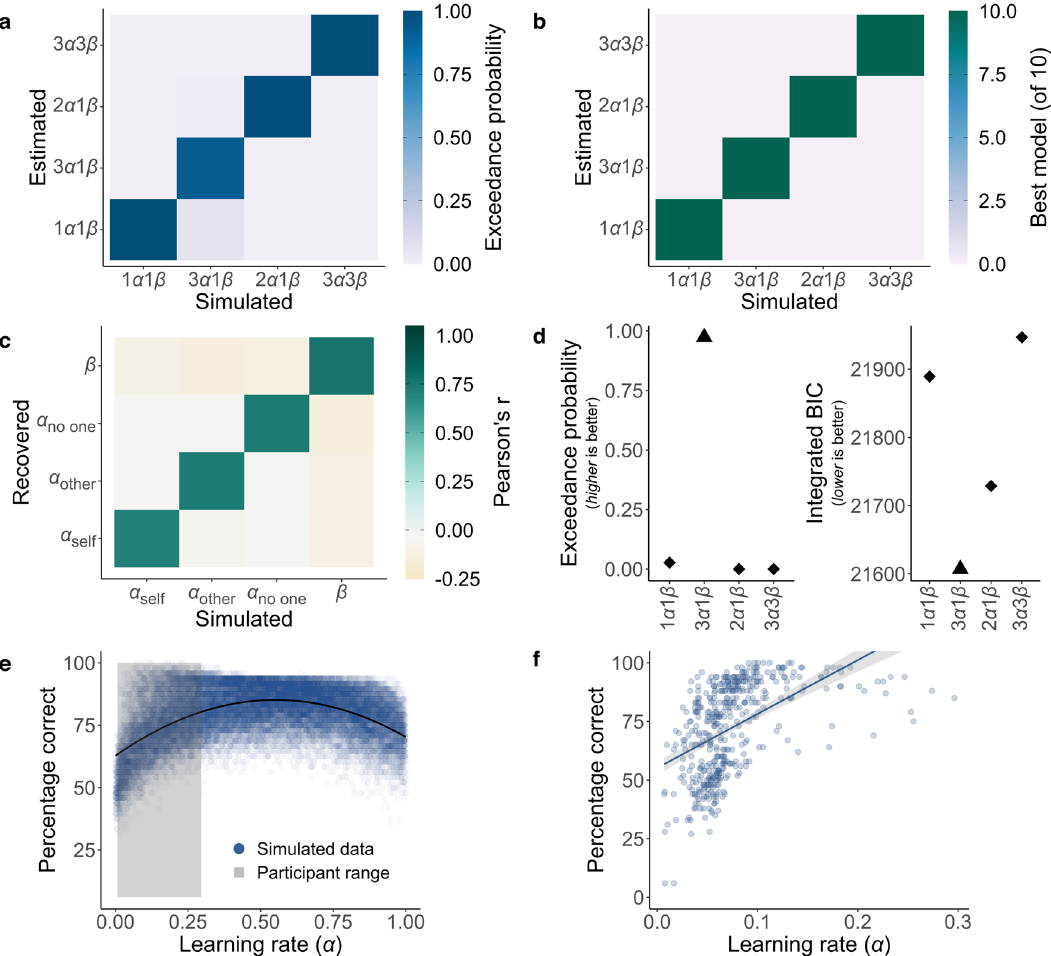
Fig. 2 Model identi fi ability, parameter recovery, model comparison and optimal learning rate. a Model identi fi ability average exceedance probability confusion matrix and b model identi fi ability best model selection confusion matrix. Data were simulated from 150 synthetic participants with each of our four models then Bayesian model selection was applied, and this procedure was repeated ten times. Identi fi ability is shown by strong diagonals. c Parameter recovery was performed on data simulated by the winning 3 α 1 β model from 1296 synthetic participants. The confusion matrix represents correlations between simulated and fi tted parameters. Stronger colours show higher values and high values on the diagonal show parameters can be recovered. d The 3 α 1 β model (triangle) is the best model on both exceedance probability and integrated Bayesian Information Criterion (BIC) fi t measures. e Average percentages of correct choices (high probability of reward option) associated with 30,000 simulated α values (10,000 synthetic participants, three recipient conditions; blue dots) show that an optimal learning rate is approximately 0.55 in this task. The range of α values for our participants was below this peak (grey shading), such that a higher learning rate was associated with better performance. f Correlation between percentage correct and learning rate across participants. There was a signi fi cant Spearman ’ s Rho correlation between learning rate and accuracy ( r s(150) = 0.58 [0.46, 0.68], P < 0.001) (see Supplementary Table 3 for each separate age group and recipient combination; r s in all cases > 0.46, P s < 0.001), n = 150 (75 young, 75 older). The shaded area represents 95% con fi dence interval. Source data are provided as a Source Data fi